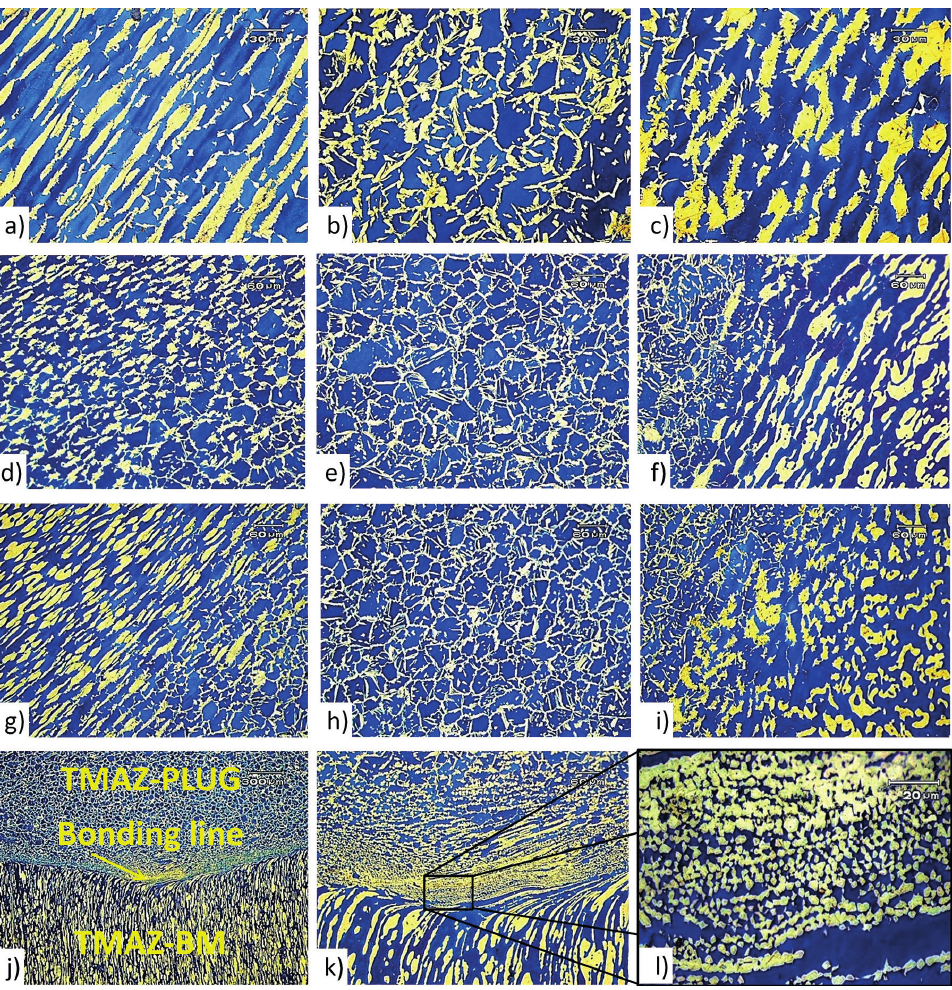
Figure 10: According to Figure 8 in different Heights, the a), d) and g) are TMAZ-Plug, the b), e) and h) are MZ, the c), f) and i) are TMAZ-BM. The j) k) and l) shows the detail of bonding tip plug. Table 3: Ratio α/γ and γ spacing.